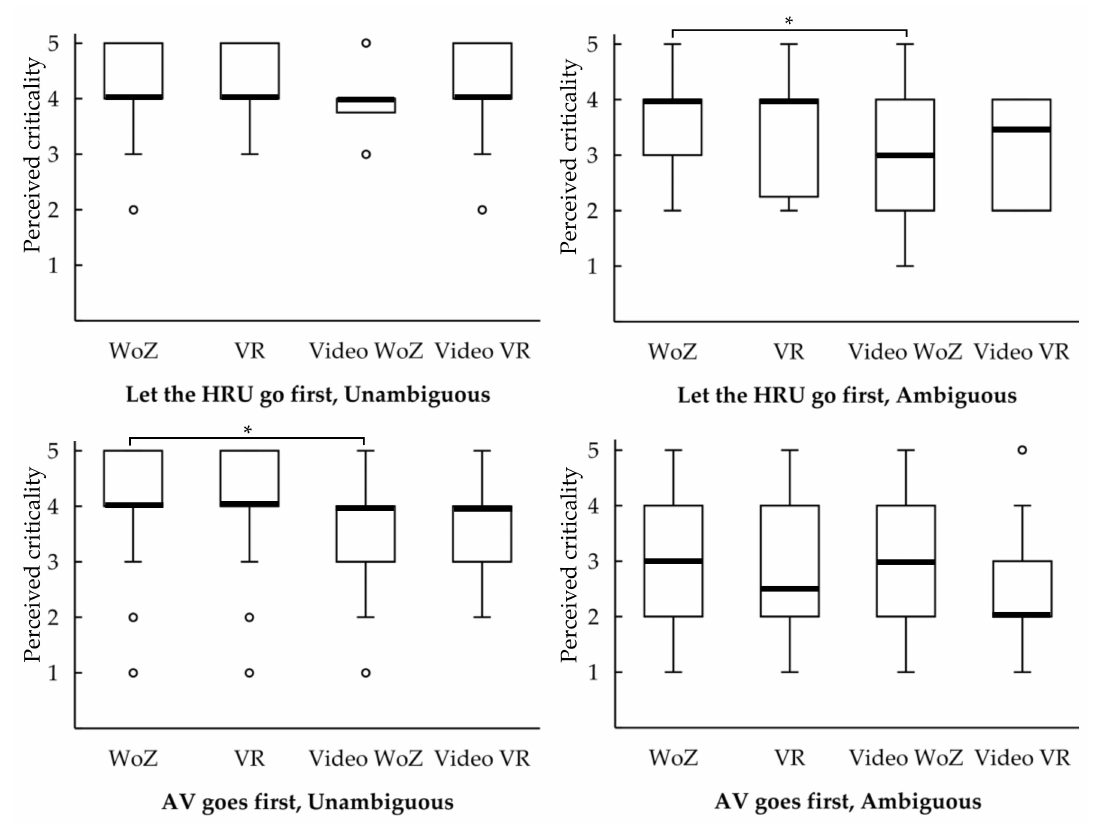
Figure 12. Boxplots for perceived criticality (1 = very critical, 5 = very uncritical), segregated by setups (* = p <